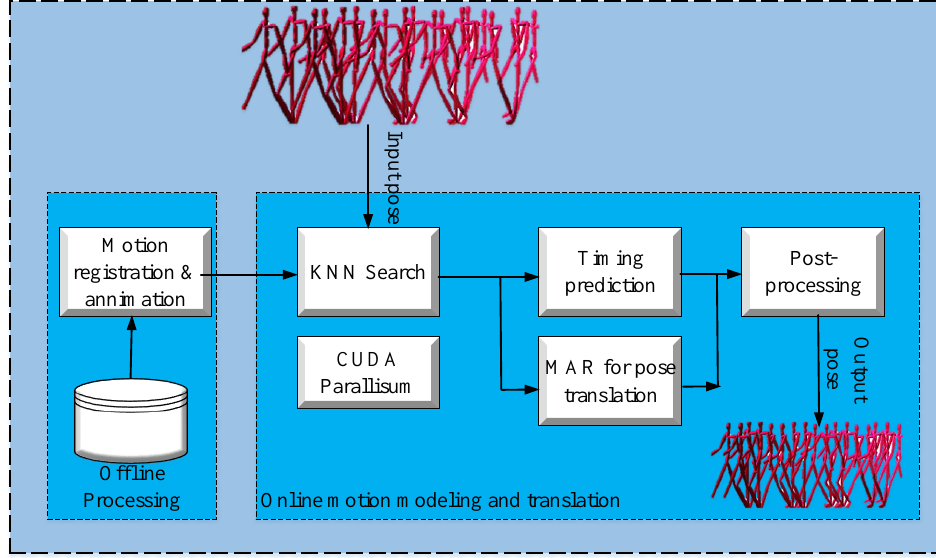
Figure 5. Regression-based motion style transfer from motion-captured